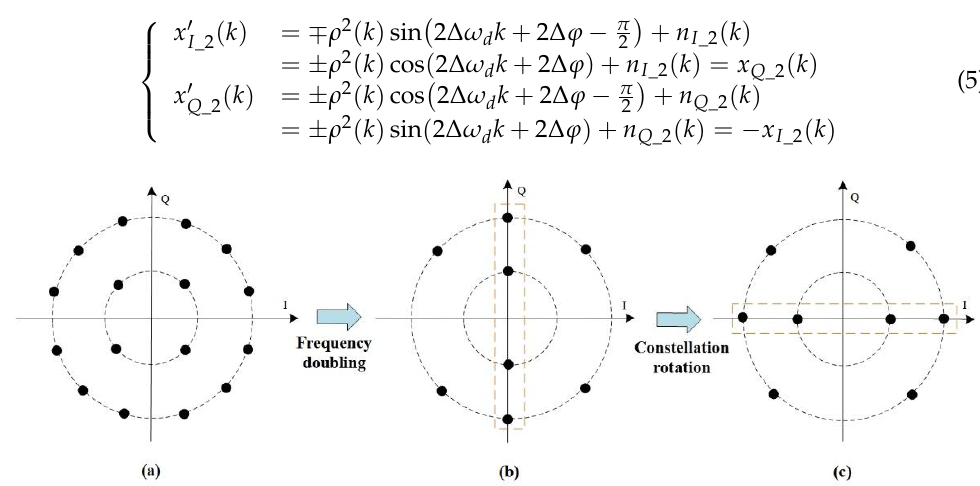
Figure 5. 16APSK constellation change diagram. ( a ) 16APSK constellation ( b ) 16APSK constellation after frequency doubling. ( c ) 16APSK constellation after frequency doubling and